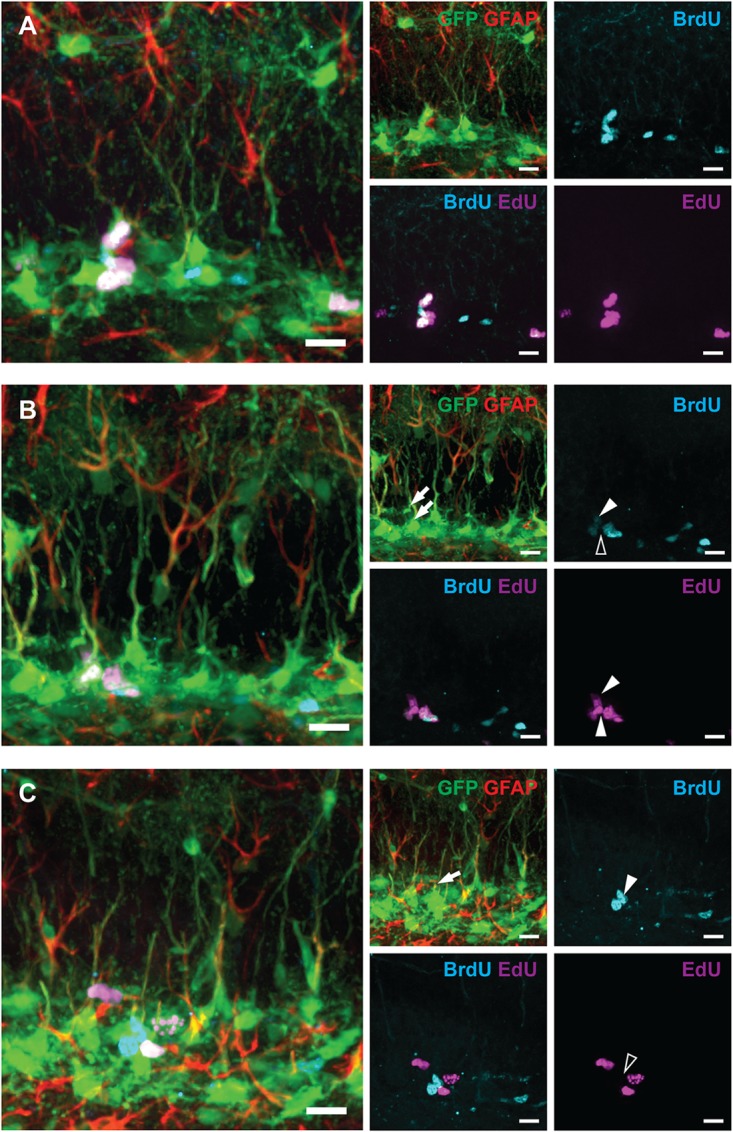
Examples of labeled RGLs and ANPs analyzed in Figure 2 (1-day experiment—scheme in Figure 1A). (A) BrdUonly, EdUonly, and BrdU+EdU+ labeled ANPs. (B) EdUonly labeled RGL [lower arrow on GFAP and GFP channels’ overlay, lower arrowhead (white) in EdU channel, and same position with no labeling shown with blank arrowhead in BrdU channel], BrdU+EdU+ labeled RGL [upper arrow in GFP and GFAP channels’ overlay, upper arrowhead (white) in BrdU channel, and upper arrowhead (white) in EdU channel], other labeled cells represent ANPs. (C) A BrdUonly labeled RGL (arrow in GFAP and GFP channels’ overlay, arrowhead in BrdU channel, and same position with no labeling shown with blank arrowhead in EdU channel), other labeled cells represent ANPs. Scale bars show 20 μm.